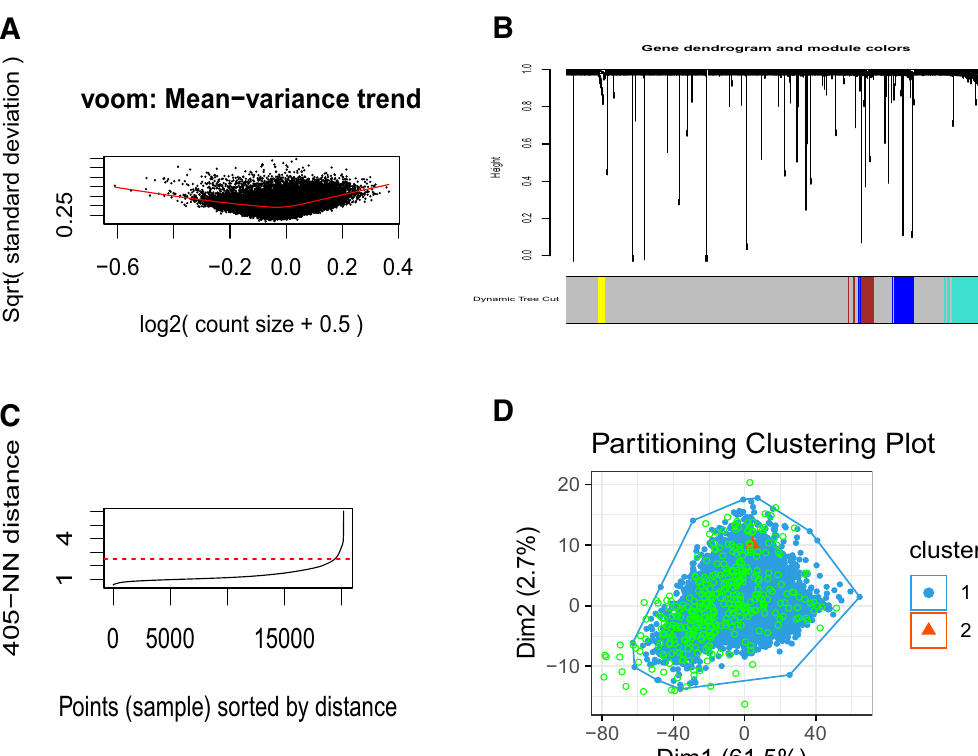
Figure 5. Plots for Voom normalization, dendrogram, KNN distance and Partitioning clustering using DBSCAN clustering algorithm for the dataset having NCBI GEO ID: GSE134379 (AD vs control in CBL). ( A ) Plot for Voom normalization for additional data (AD vs control in CBL). Voom normalization was used on the set of non-noisy features of the resultant clusters obtained from the pre-filtering analysis by DBSCAN clustering. ( B ) Dendrogram plot with color thresholding using dynamic tree cut method for the comparison of AD with control in CBL. ( C ) KNN distance plot to find knee point ( = 2.5 marked by red dotted line) used as EPS in DBSCAN clustering algorithms for AD vs control in CBL. ( D ) Partitioning clustering plot using DBSCAN clustering algorithm for AD vs control in CBL. Two clusters had been identified, among which the blue cluster contained 19,711 core (seed) features and 71 border features, and the red cluster had only 10 core features. In addition, a total of 398 unclustered (outlier/noisy) features (denoted by light green dots) had been